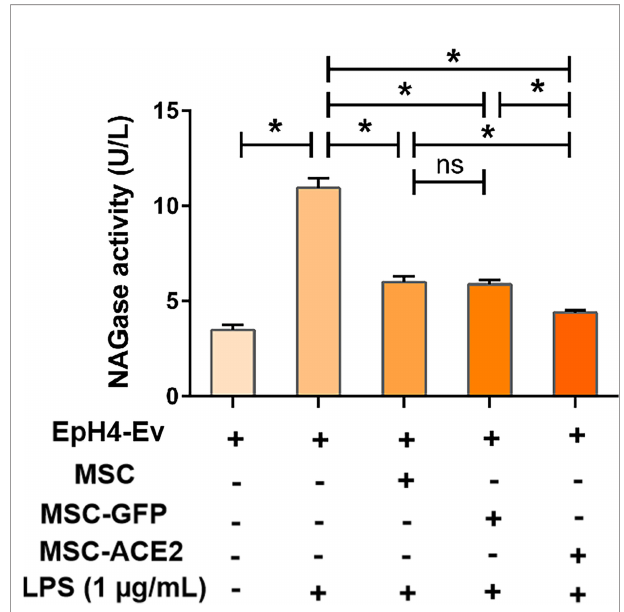
FIGURE 2 | MSC-ACE2 inhibits the LPS-induced elevation of NAGase activity in EpH4-Ev cells. Detection of NAGase activity incell culture supernatant according to kit instructions. Experiments were repeated three times and data were presentedas themean ± SEM (n = 4). * P < 0.05 (signi fi cantly different) between the indicatedgroups, ns, nosigni fi cant